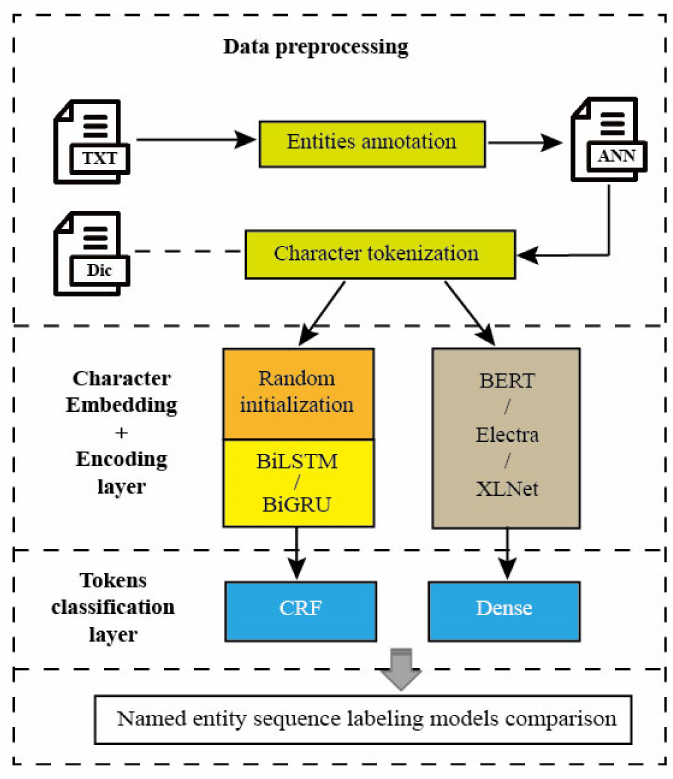
Figure 4. Framework for the named entity sequence labelling model